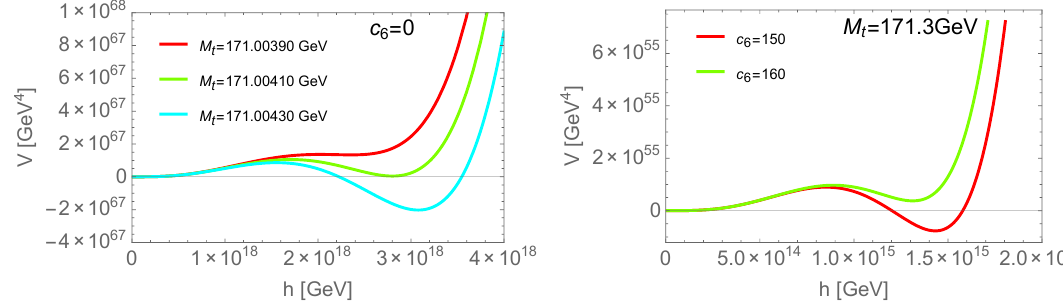
Figure 1 . The 4-dimensional Higgs potential as a function of the physical Higgs (cid:12)eld h , eq. (2.1) . In the left panel, we put c 6 = 0. The potential has AdS, (cid:13)at or dS vacua depending on the value of the top mass. In the right panel, the c 6 term is included while M t is (cid:12)xed. We again have AdS, (cid:13)at or dS minima corresponding to the value of c 6